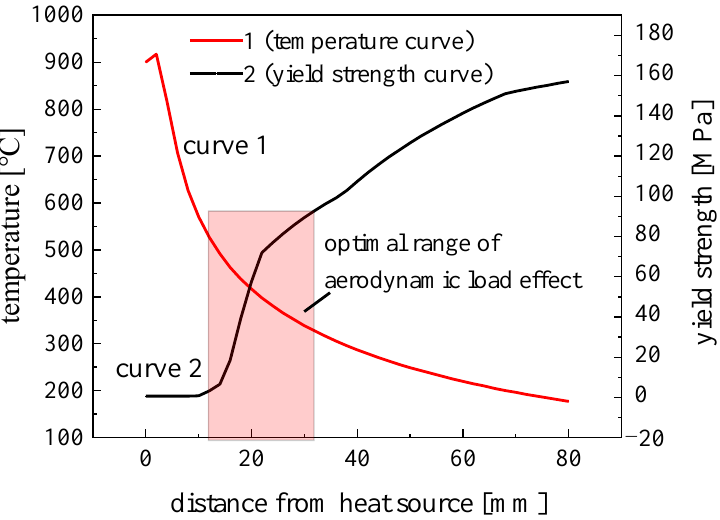
Figure 7. Relationship between temperature and yield strength at different positions from the arc. Table 2. Range of the aerodynamic loads at different loading distances. Loading Distance